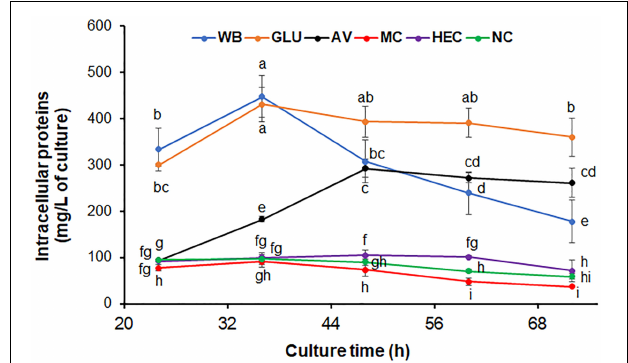
FIGURE 2 | Growth curves of P. oxalicum strain (cid:49) PoxKu70 . Fresh spores of (cid:49) PoxKu70 were inoculated into medium containing each carbon source and cultivated for 24 to 72 h. Total intracellular proteins from all the P. oxalicum hyphae in the culture were extracted and measured. The lowercase letters indicate significant difference at p < 0.05 probability level, assessed by Student’s t -test. HEC, 2-hydroxyethyl cellulose; MC, methyl cellulose; WB, wheat bran; AV, Avicel; NC, no carbon source; GLU, glucose.